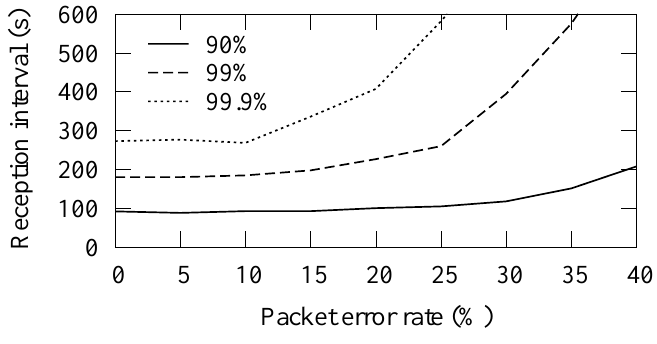
Figure 26. Availability in TUTWSN using the reliable data forwarding (12 sources, 5.5 B/s offered